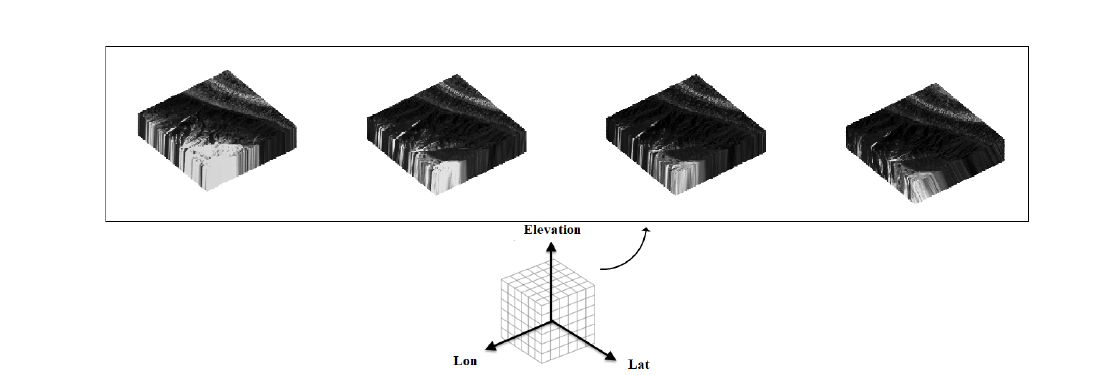
Figure 1. Graphical representation of image volumes computed for each tile of object space. Here, as an example, four image volumes are computed from four different PlanetScope Images covering the object space are shown.